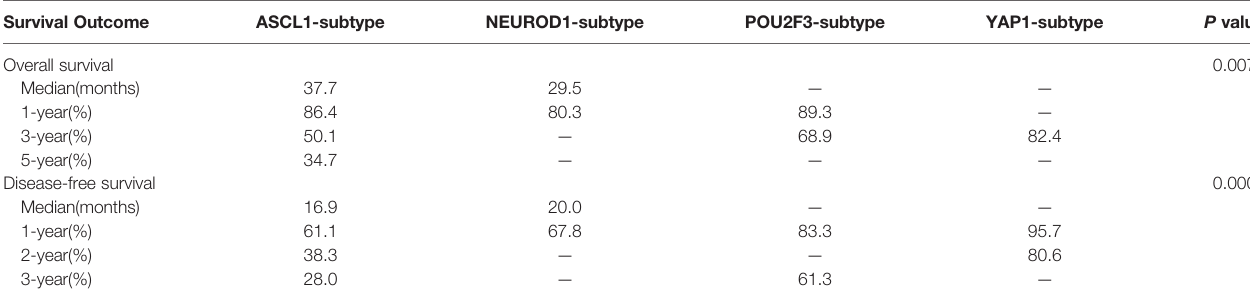
TABLE 3 | Survival comparison of molecular subtypes determined by immunohistochemical staining in primary small cell lung cancer tumors. Survival